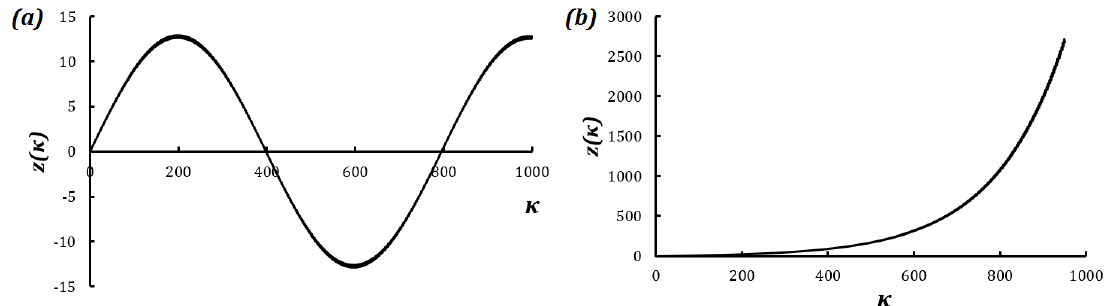
Figure 1. Ince – Strutt stability diagram for the Mathieu equation. The shaded region represents the domain of stable solutions for a tensile-loaded beam.